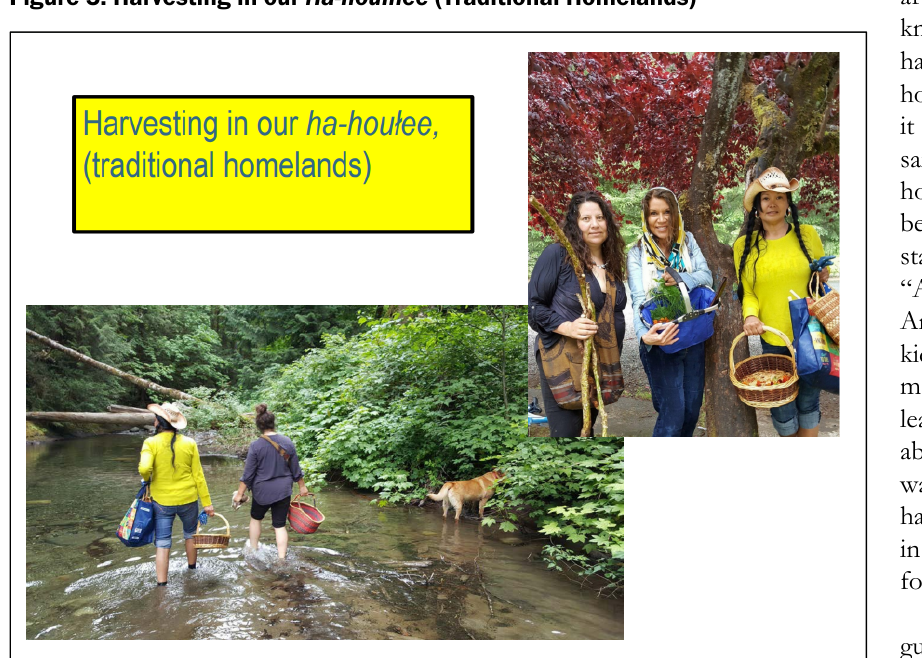
Figure 5. Harvesting in our Ha-hou ł hee (Traditional Homelands)